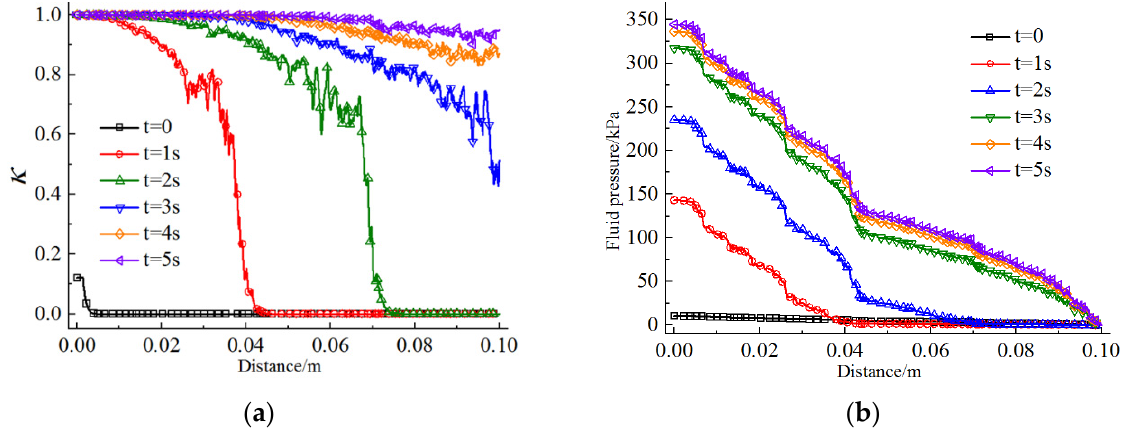
Figure 2. Distribution of grout suspension at different times .